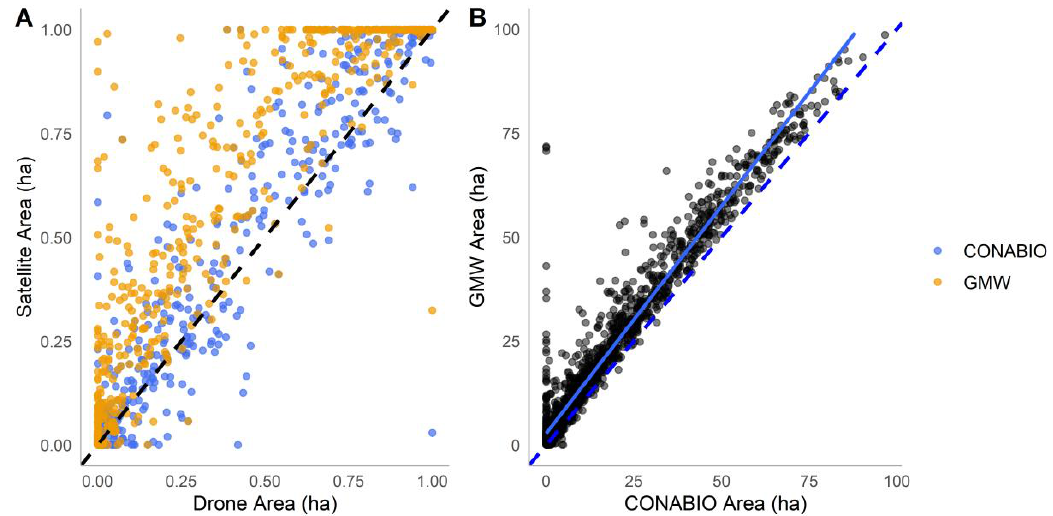
Figure 4. The differences between our three data sources are displayed. Each point represents one fishnet cell. The x -axis is the mangrove area identified by the named source in hectares. ( A ) CONABIO (blue) and GMW (orange) data plotted against drone measurements of mangrove extent for each one-hectare fishnet cell. ( B ) Scatterplot of the total mangrove extent of CONABIO and GMW for the same 100-hectare fishnet cell. The bold line is the linear relationship between the two datasets (y = 1.094x + 2.796, R² = 0.9444). The dashed lines represent the linear relationship y = x. We found that consensus on mangrove identification rose with the increase in mangrove area.